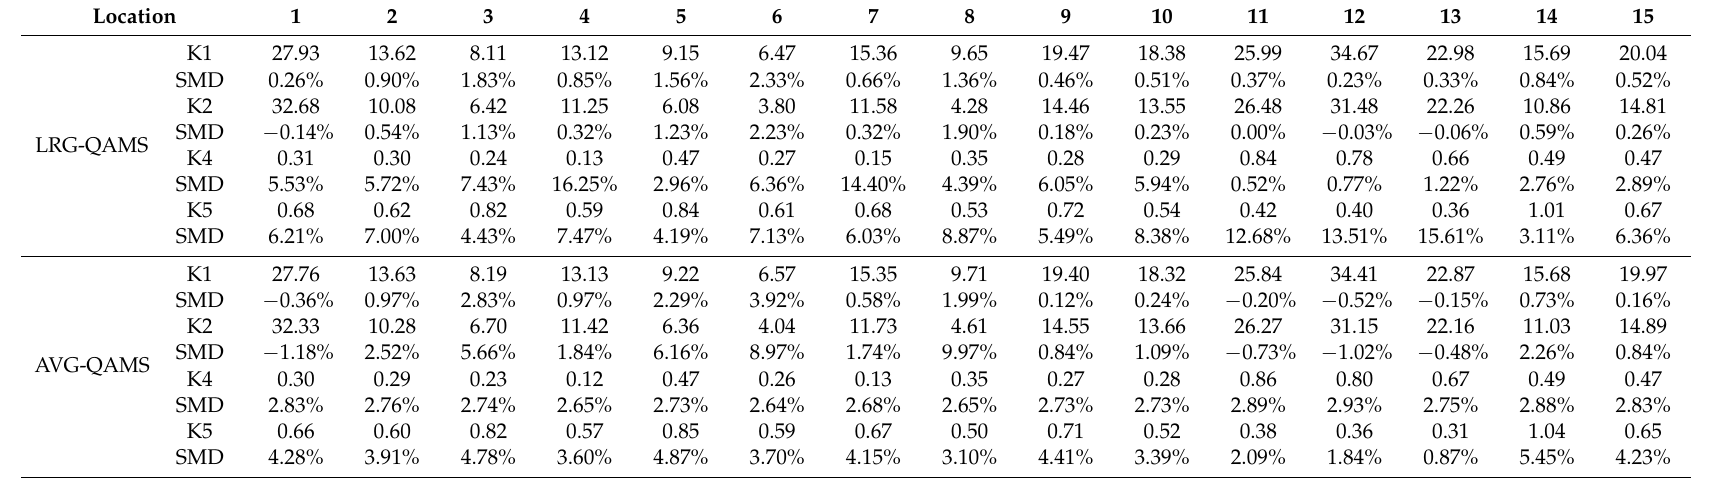
Table 8. The content of the marker components detected at 210 nm using both LRG-QAMS and AVG-QAMS method for data processing